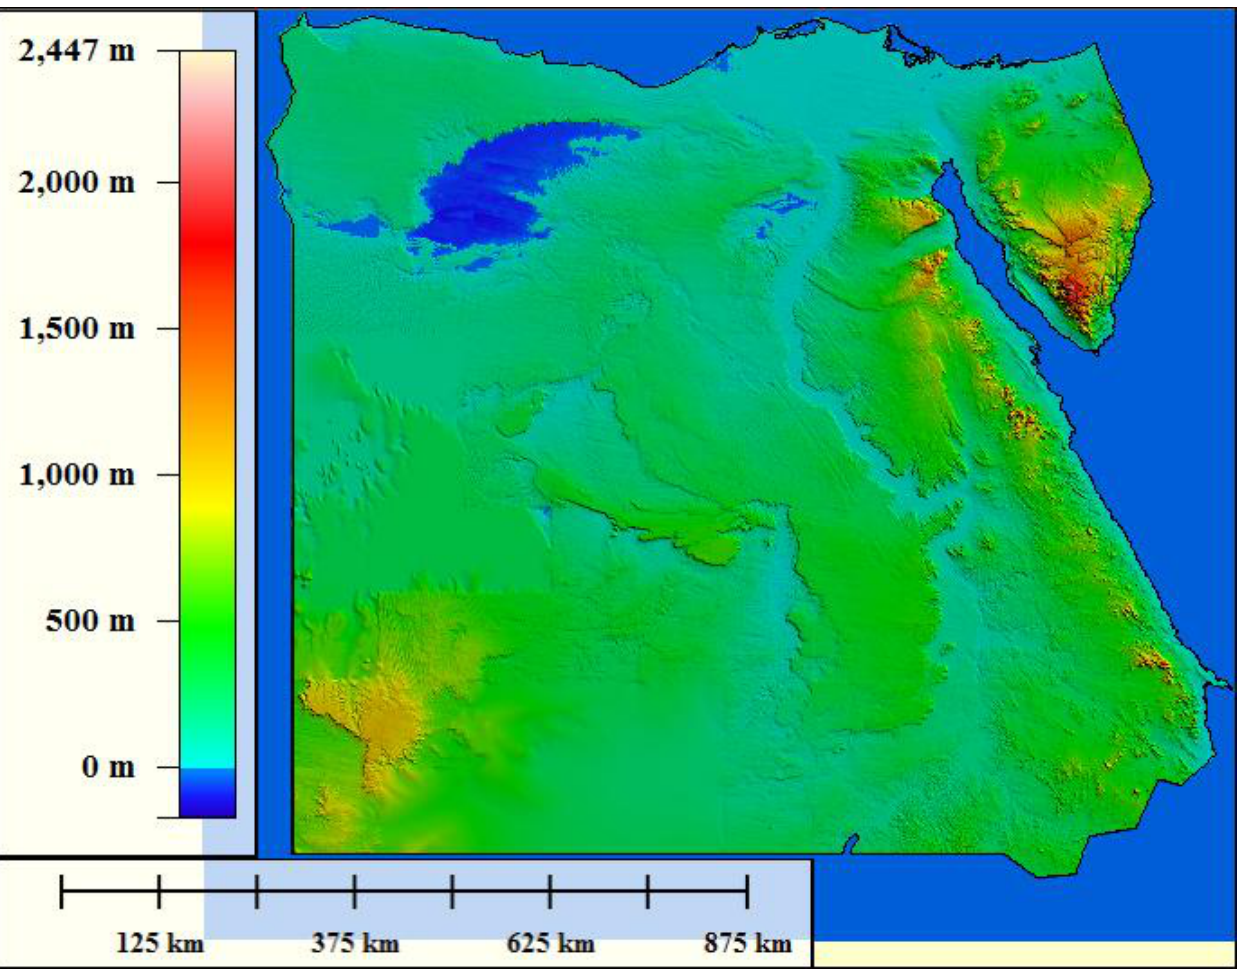
Figure 1. The Shuttle Radar Topography Mission (SRTM) digital elevation model DEM of the study area, forming a geographic grid referenced to WGS-84 ellipsoid with spacing 3 arc seconds. The elevation range is within the interval [−170, 2,447] m. The Nile River crossing the east portion of Egypt from north to south is easily recognized as the elongated, smooth, low relief region in respect to the surrounding